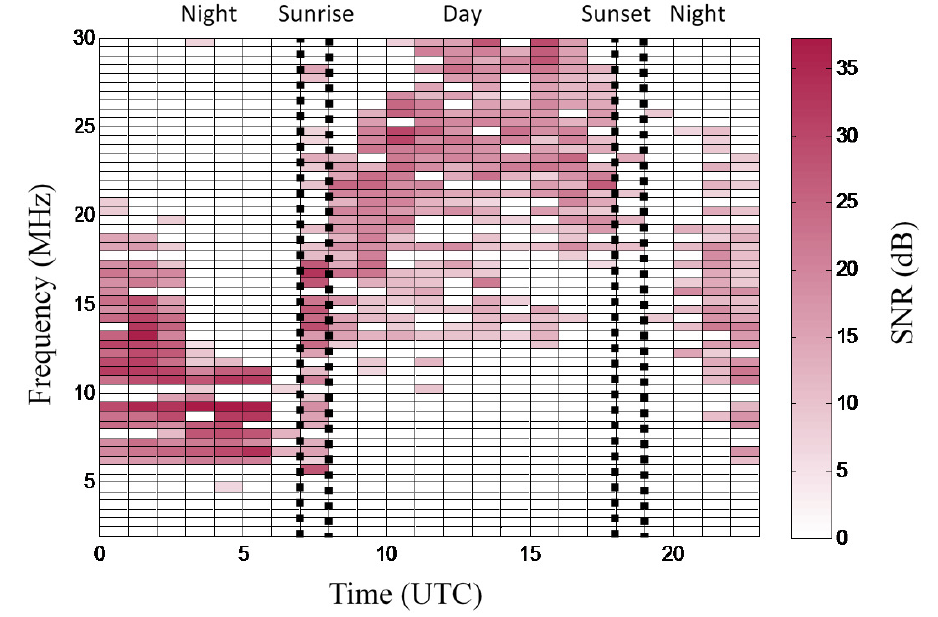
Figure 12. SNR of 17 February (in dB) over a bandwidth of 10 Hz, in which the regions of day, night and the time just after sunrise and the time just after sunset can be appreciated.